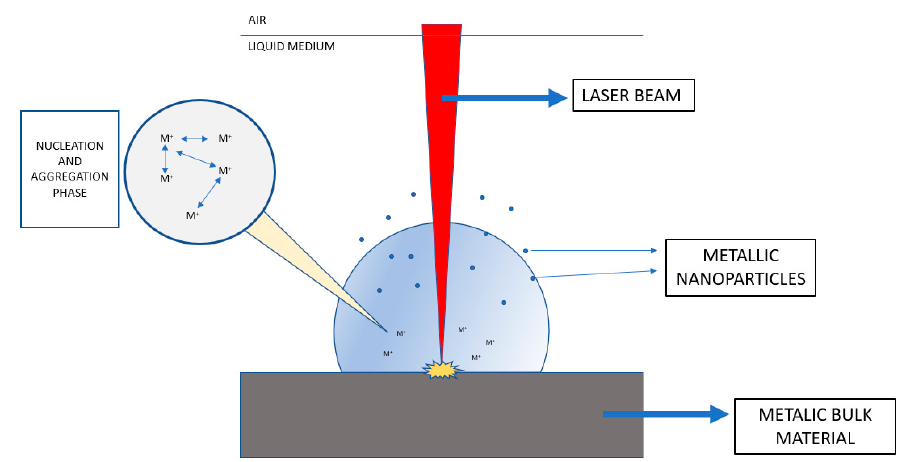
Figure 1. Laser beam synthesis representation (based on [14–16]).